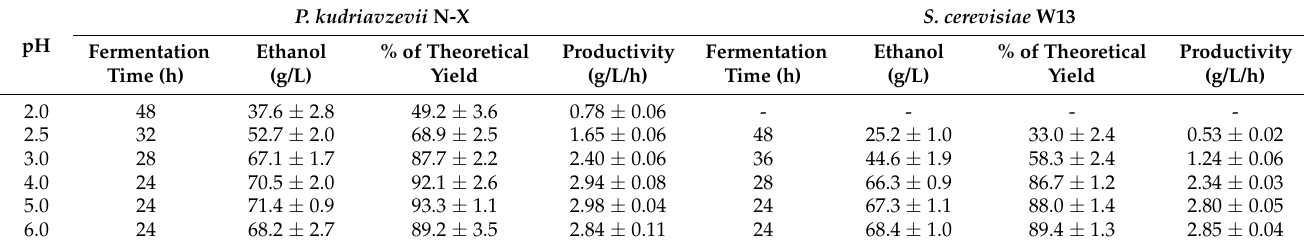
Table 1. Ethanol production of Pichia kudriavzevii N-X and Saccharomyces cerevisiae W13 under different initial pH conditions. P. kudriavzevii N-X pH Fermentation Time